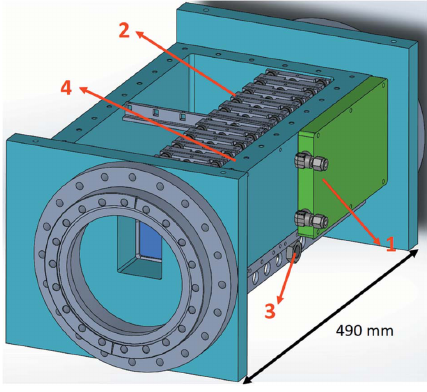
Figure 6 Diagram of the attenuator: (1) water cooling plate, (2) aluminium foil carrier, (3) pneumatic actuator, and (4) chamber cooling sidewall.